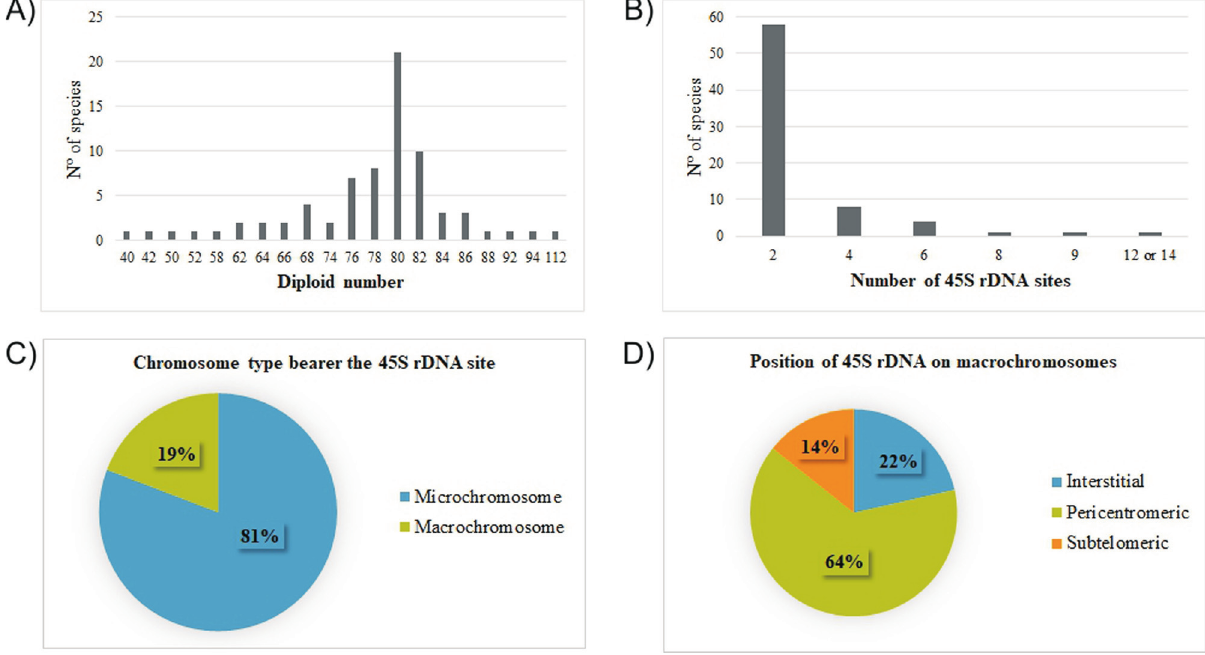
Figure2 -Chromosomallocationofthe45SrDNAsitesinall73birdspeciesanalyzedinthepresentstudy.(A)variationinthediploidnumber;(B)varia- tion in the number of 45S rDNA bearer chromosomes; (C) the proportion of the species with 45S rDNA located in macrochromosomes or microchromosome; (D) location of the 45S rDNA cluster in the chromosome